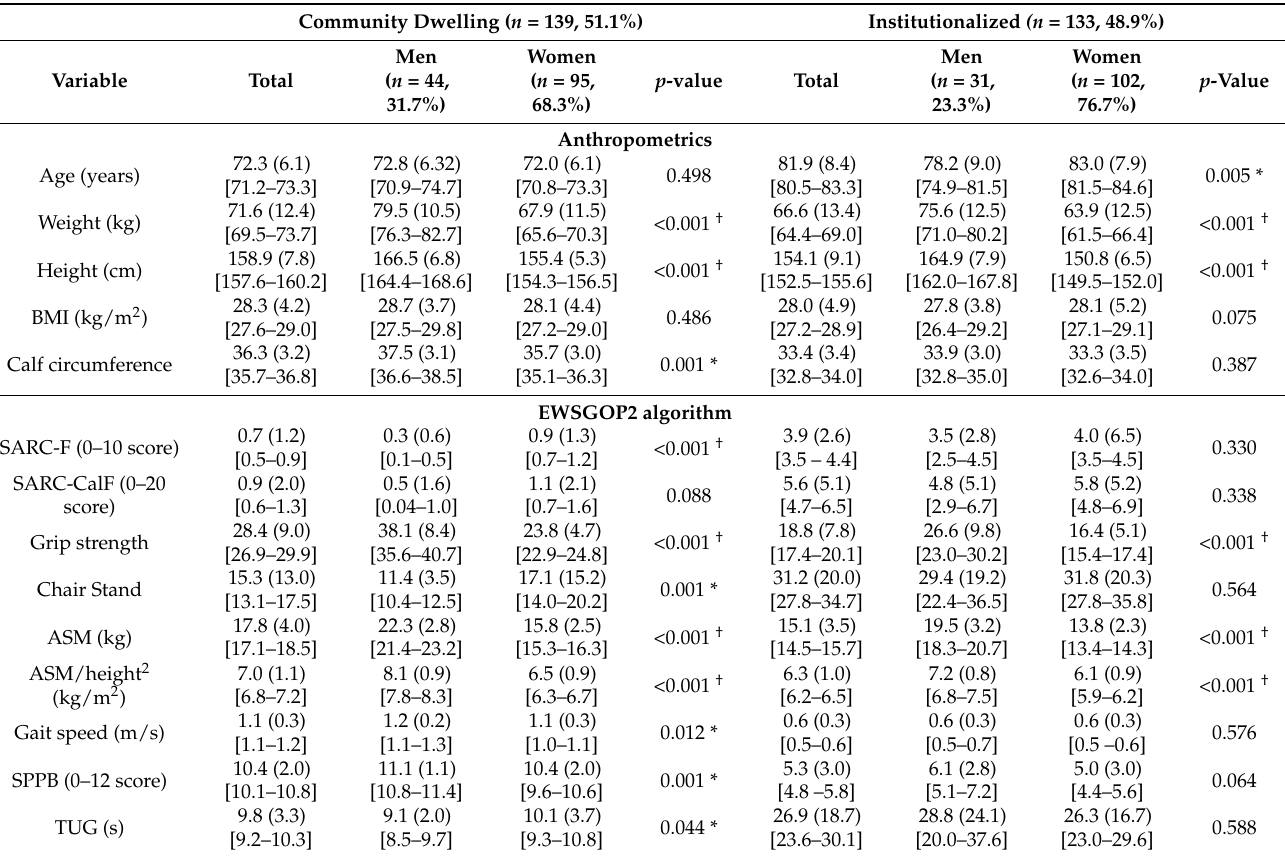
Table 2. Characteristics of the participants ( n = 272) according to setting and gender: mean (standard deviation) and [95% confidence interval].